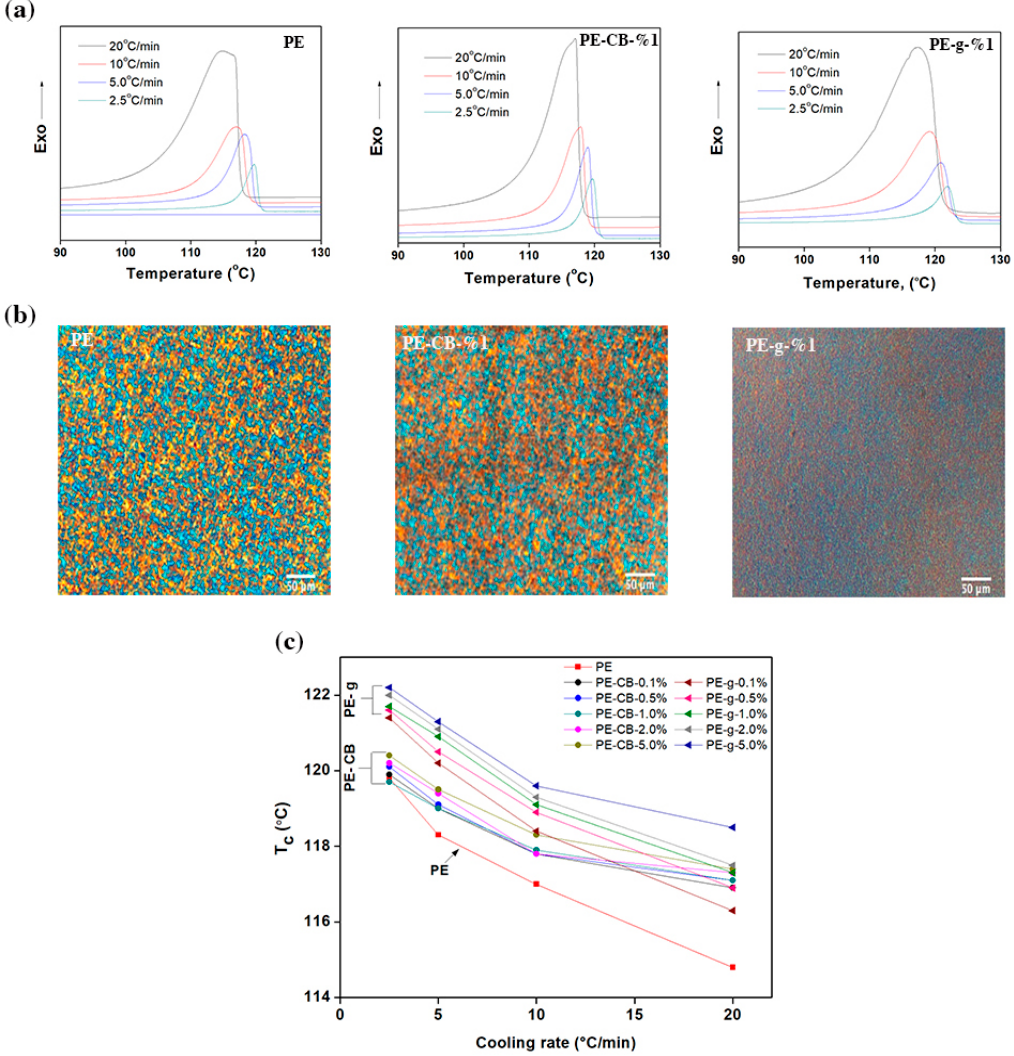
Figure 3. The effect of carbon black and graphene on the crystallisation kinetics of the multimodal-HDPE. ( a ) Non-isothermal DSC traces of the neat multimodal-HDPE, PE-CB-1% and PE-g-1%. ( b ) PLM micrographs represent the effect of graphene and carbon black on the spherulitic morphology of the multimodal-HDPE. ( c ) Effect of carbon black and graphene fillers on the peak crystallisation temperature ( T c ) of the multimodal-HDPE at different cooling rate. Table 2. Nano-isothermal crystallisation parameters of multimodal-HDPE, PE-g and PE-CB. Sample Neat